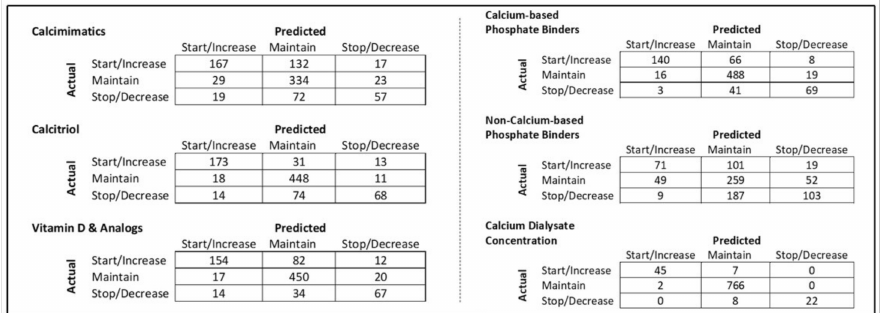
Figure 13. Confusion matrix indicating compliance between domain model and routine clinical